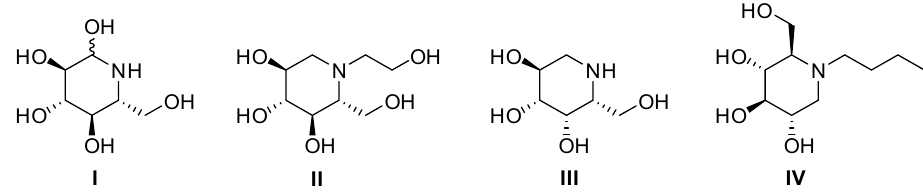
Figure 1. Structures of nojirimycin ( I ), miglitol ( II ), migalastat ( III ), and miglustat ( IV ).